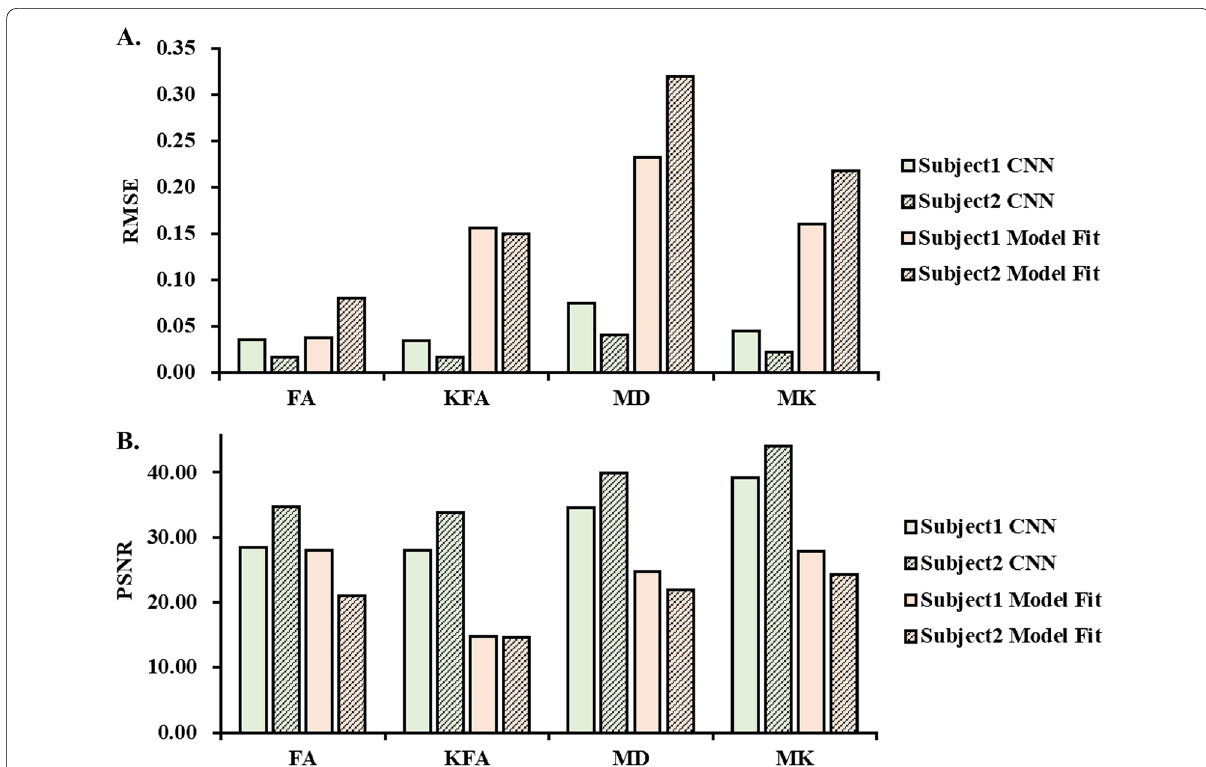
Fig. 3 The testing about the accuracy of CNN-estimated measures. Note. PSNR